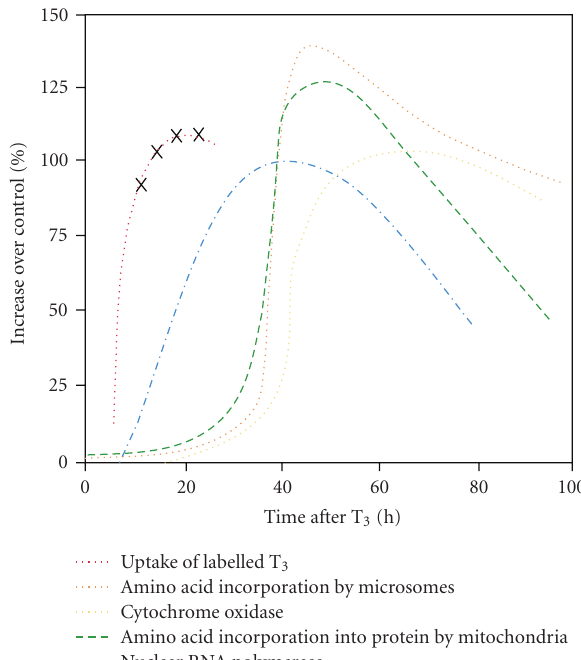
Figure 1: An idealized representation of the time course of response of some activities of nuclei, mitochondria, and microsomes from livers of thyroidectomized rats after a single injection of 20 μ g T 3 /100g. body wt. The stimulatory e ff ects are expressed as % increase in specific activity in the di ff erent subcellular fractions from T 3 -injected animals over control animals. The main features are the following: (a) mitochondrial respiration (here expressed as cytochrome oxidase activity) reached a peak after amino acid incorporation into protein by microsomes and mitochondria; (b) the increase in protein synthetic capacity of the two organelles was coupled, following a relatively long lag period after hormone administration; (c) nuclear RNA polymerase activity was enhanced several hours before cytoplasmic protein synthesis and BMR. The time course of nuclear accumulation of T 3 ( ×···× ; [18]) is superimposed on that of the hormonal e ff ects on mitochondrial, transcriptional, and protein synthetic activities (Data assembled from